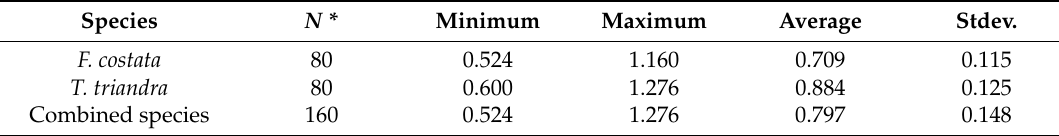
Table 4. Descriptive statistics of the measured species AGB (kg/m 2